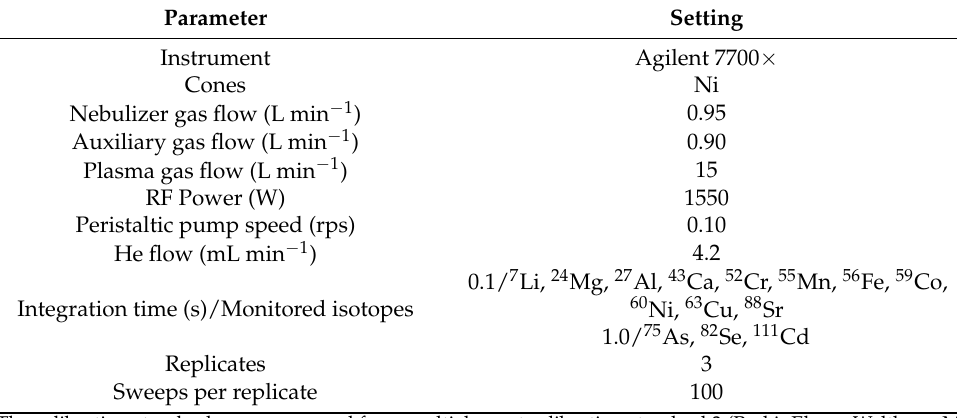
Table 1. Operating conditions of